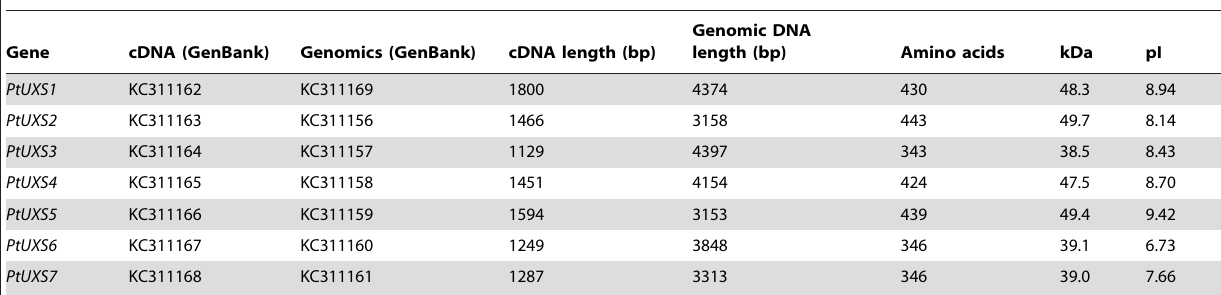
Table 1. UXS gene family members in Populus .